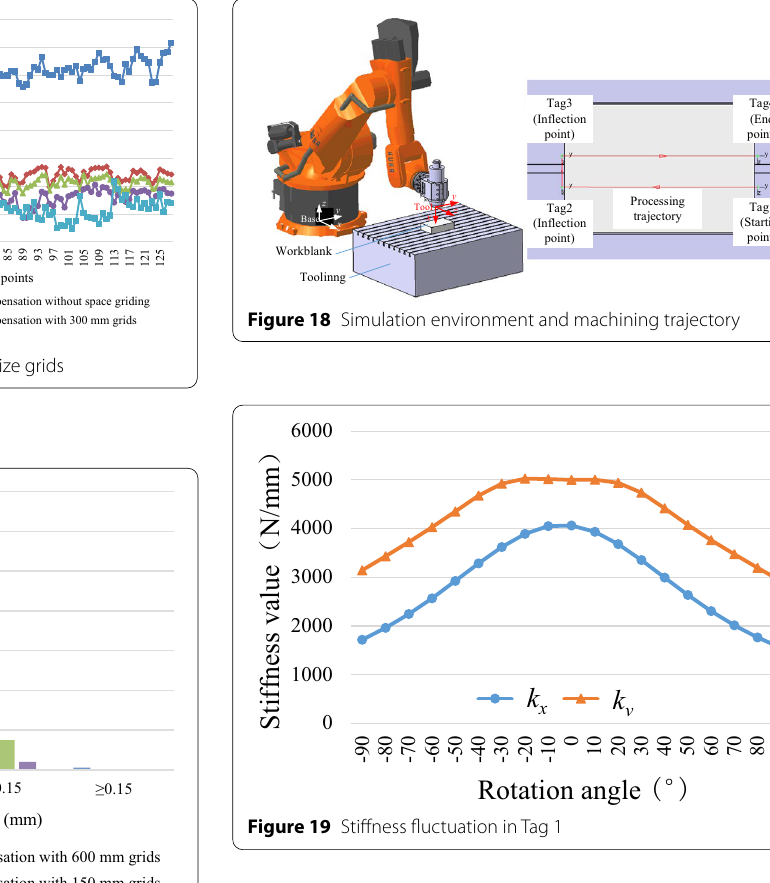
Figure 17 Error distribution after compensation with different grids